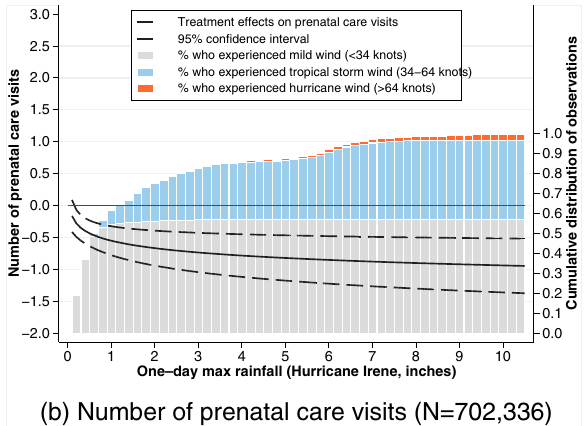
Fig. 2 | Estimated treatment effect of Hurricane Irene exposure on the month thatprenatalcarebeganandthenumberofprenatalcarevisits. Thetreatment effectsmeasured forprenatalcareindicatorsincluding: a Themonththatprenatal care began and b the total number of prenatal care visits. Rainfall at residential addresswasusedasanindicatorofexposureintensityrepresentedbytheone-day maximumrainfallfrom August 14,2011 to September4, 2011,which encompassed